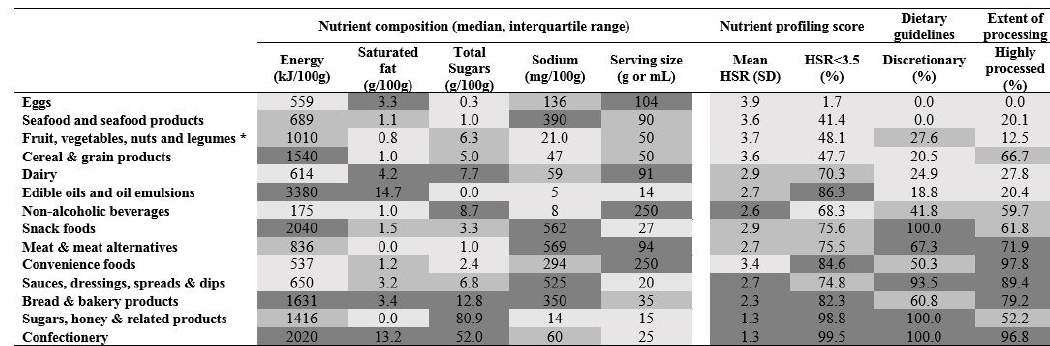
Figure 4. Coherence of ranking of the healthiness of 14 Australian packaged food categories according to nutrient composition, nutrient profile, dietary guidelines and extent of processing. The upper five ranked for each measure were coloured light grey, the lower five dark grey and the middle four medium ‐ grey. Categories on the heat map were listed according to average rank across proportion HSR < 3.5, proportion discretionary and proportion highly processed. * Excludes herbs and spices. g = grams; mL = millilitres; mg = milligrams. Discretionary foods: energy ‐ dense and nutrient ‐ poor foods not necessary for providing the nutrients the body needs [22,23]. Highly ‐ processed foods: multi ‐ ingredient industrially formulated mixtures processed to the extent that they are no longer recognizable as their original plant/animal source and not typically consumed as additions [24].